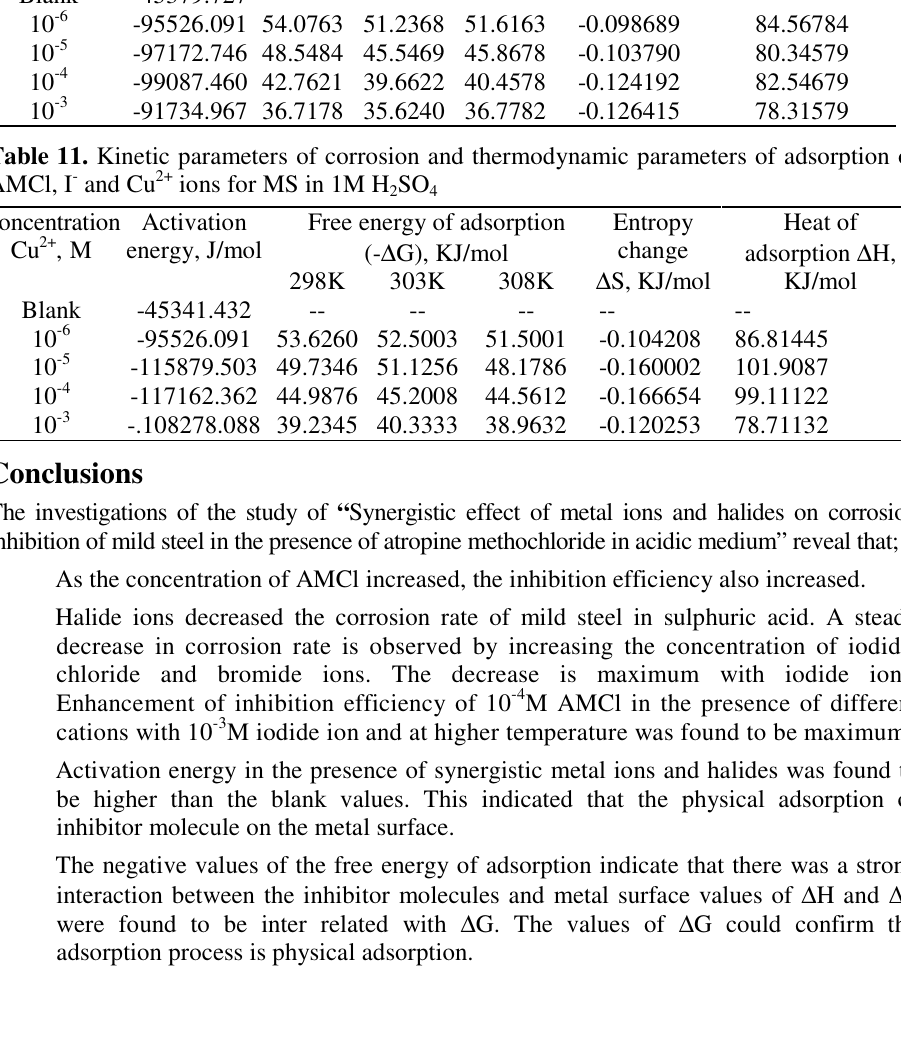
Table 10. Kinetic parameters of corrosion and thermodynamic parameters of adsorption of AMCl, I - and Ni 2+ ions for MS in H